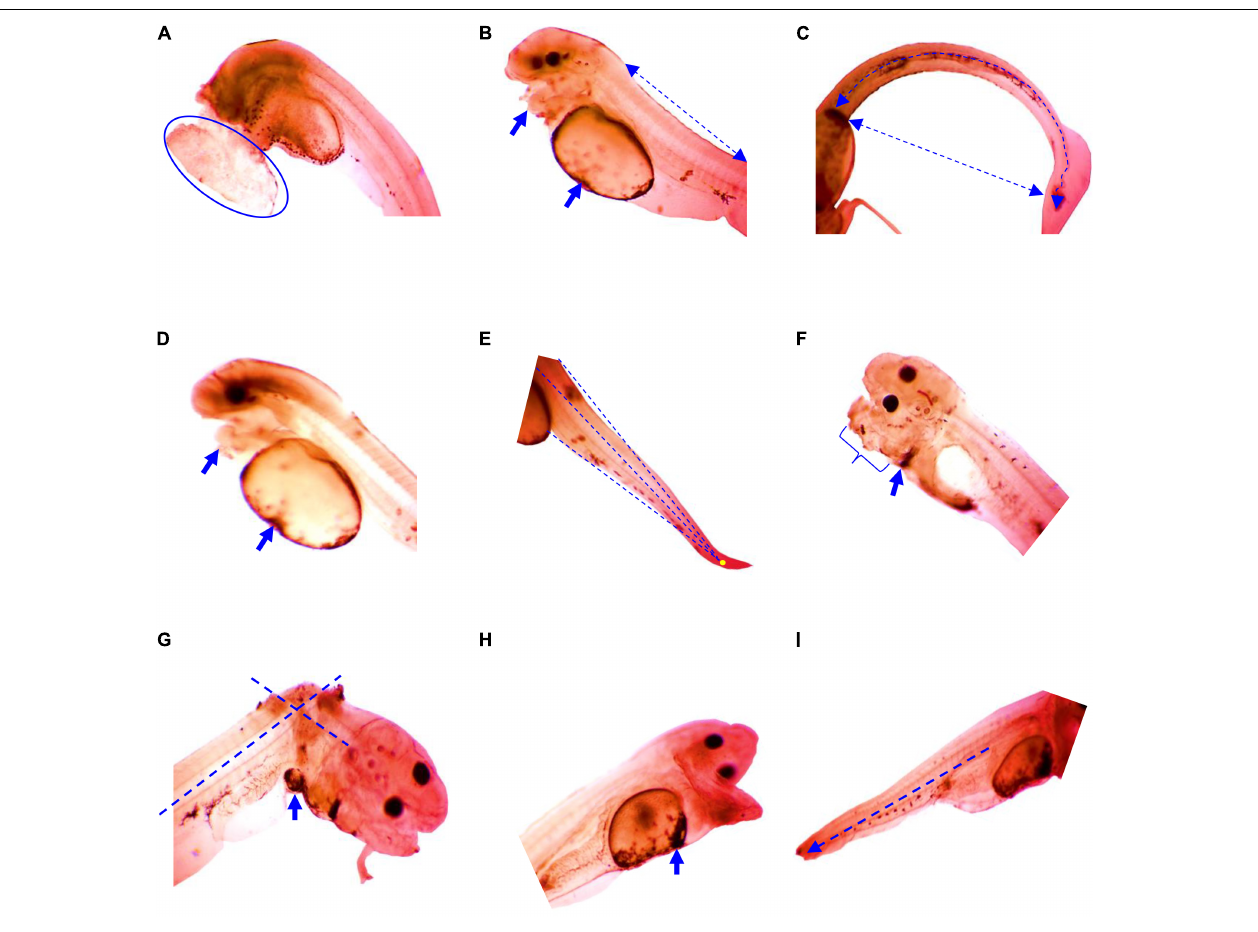
FIGURE 2 | Deformities in larvae of striped catfish exposed to different salinities; (A) yolk sac ulceration, anterior curve at 6 ppt salinity after 8 h 40 min, (B) axis-curve or bent axis in either direction (arrow line), swim bladder inflate, pericardial edema at 10 ppt salinity after 15 h 45 min (arrow), (C) spine scoliosis at 6 ppt salinity after 17 h 30 min (arrow curve), (D) pericardial malformation at 4 ppt salinity after 18 h (arrow), (E) notochord curve and tail bent at 10 ppt salinity 27 h 25 min, (F) jaw and pericardial edema at 4 ppt salinity after 27 h 40 min (arrow), (G) stretched heart, pericardial edema at 8 ppt salinity after 36 h 25 min, (H) yolk sac edema at 10 ppt salinity after 43 h 35 min (arrow), and (I) shortage end tail at 6 ppt salinity after 44 h 50 min (arrow line). Scale bar = 50 µ